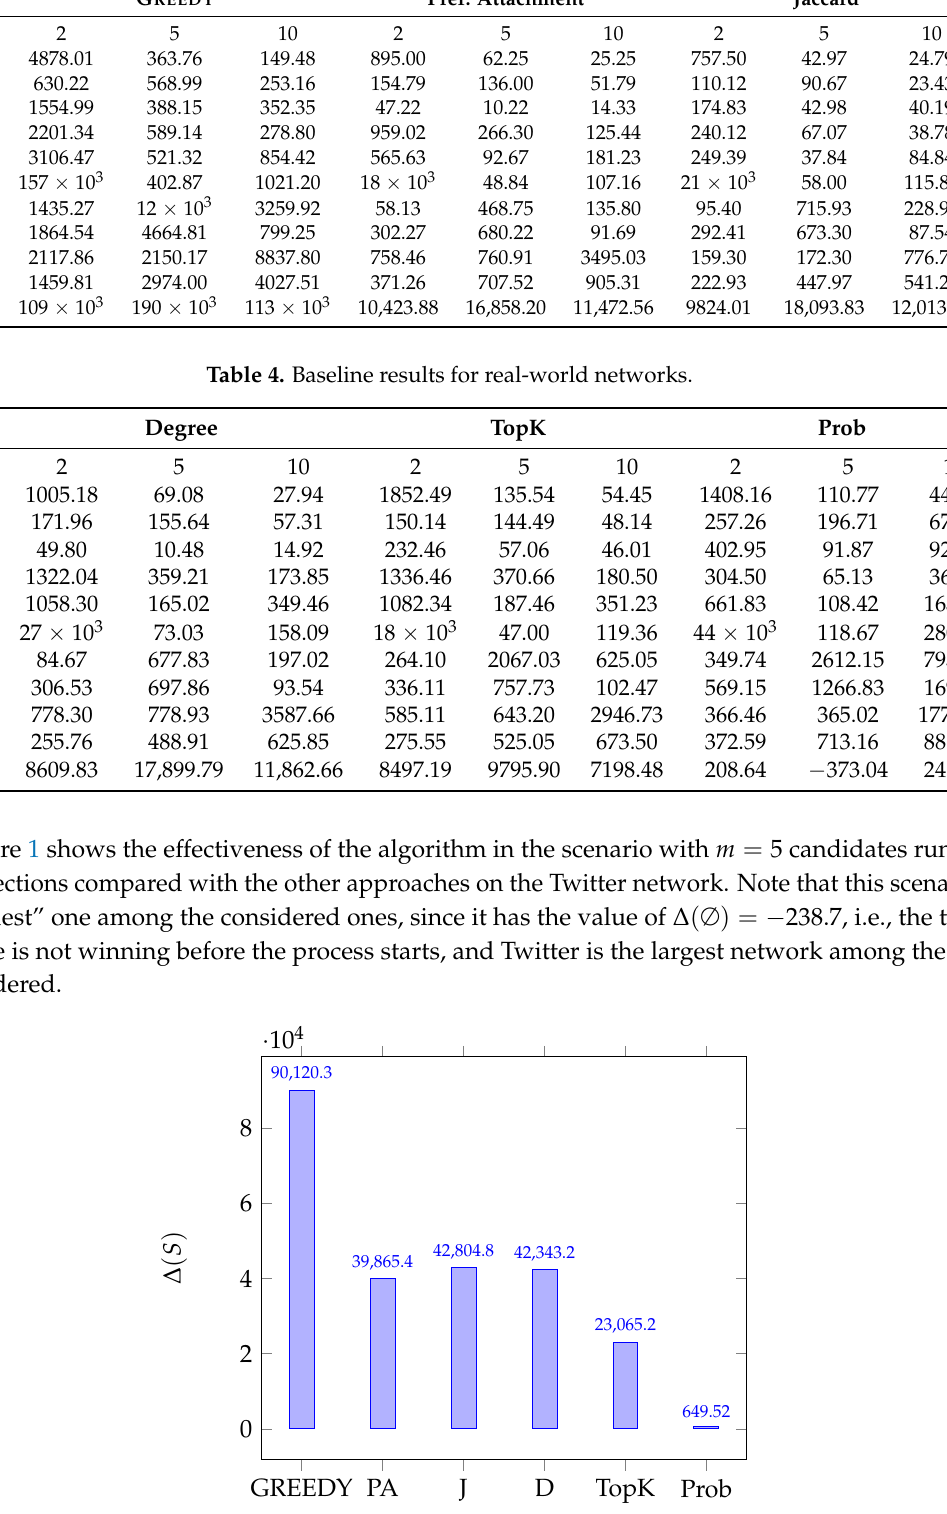
Figure 1. Value of ∆ ( S ) in Twitter